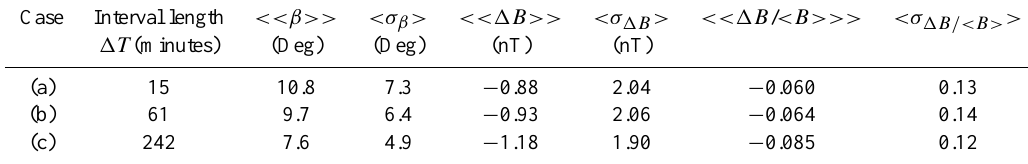
Table 1. The final averages and sigmas for β *, 1B + , and 1B / <B> + for three smoothing interval lengths. Case